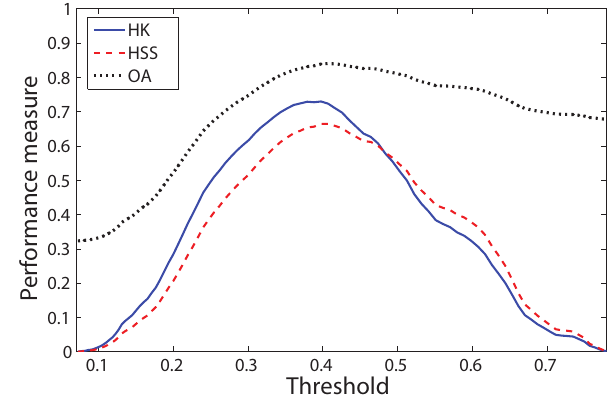
Fig. 2. Performance curves (HK, HSS, OA) computed on the validation data set. The decision threshold t pre-selected on the testing set is 0.37.